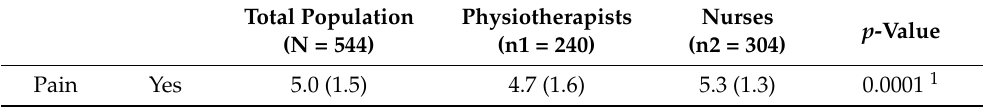
Table 7. VAS scores in physiotherapists and